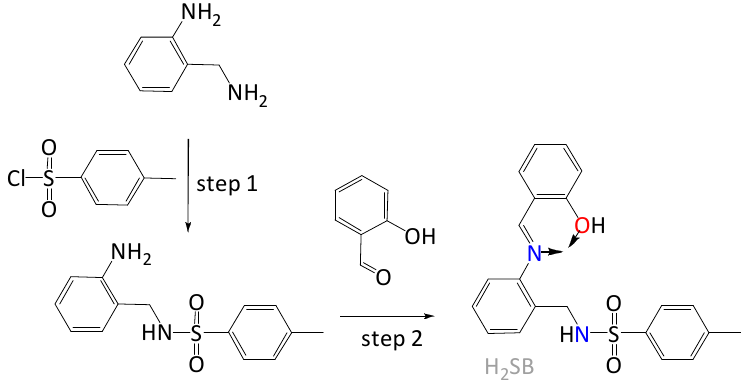
Figure 1. Schematic representation of the easy synthesis of ( E )- N -(2-((2-hydroxybenzylidene)amino)benzyl)-4-methylbenzenesulfonamide (H 2 SB) with the metal binding site indicated by arrows.